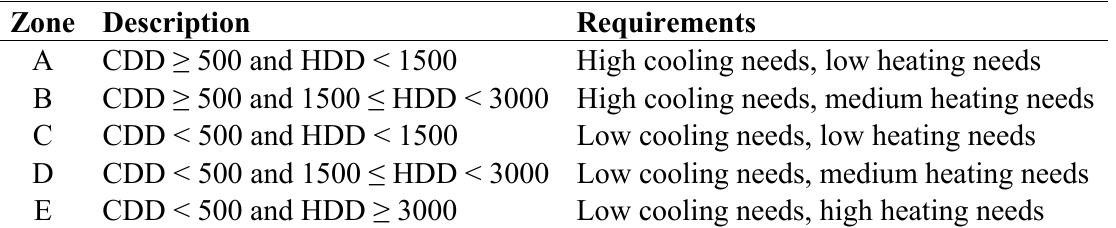
Table 1. Presentation of the proposed scheme for establishing climatic zones in the European region (2nd